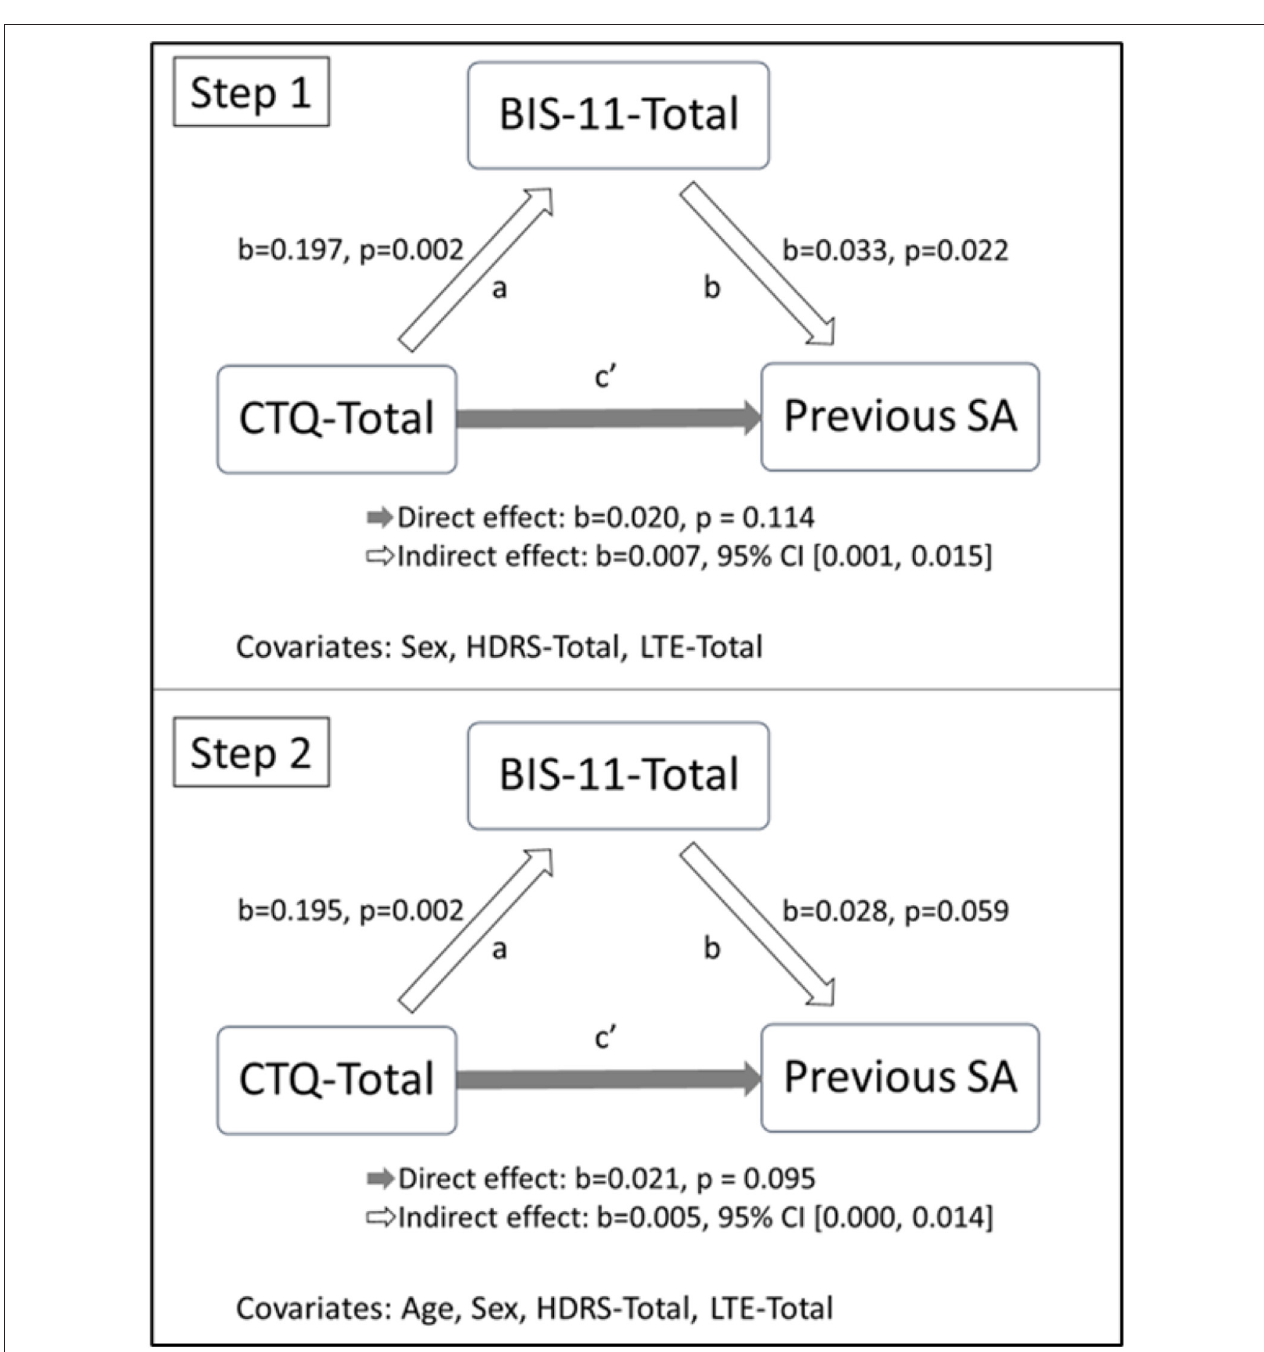
FIGURE 1 | Mediation models of the association between the CTQ-SF-Total score and history of previous SA through BIS-11-Total score. CTQ-SF, Childhood Trauma Questionnaire-Short Form; BIS-11, Barratt Impulsiveness Scale; SA, Suicide Attempt; HDRS, Hamilton Depression Rating Scale; LTE, Brugha’s List of Threatening